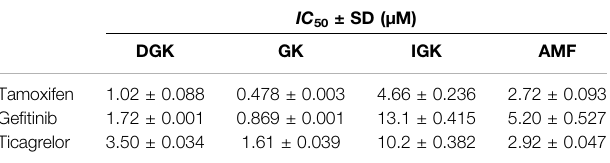
TABLE 3 | IC 50 of bi fl avones toward clinical